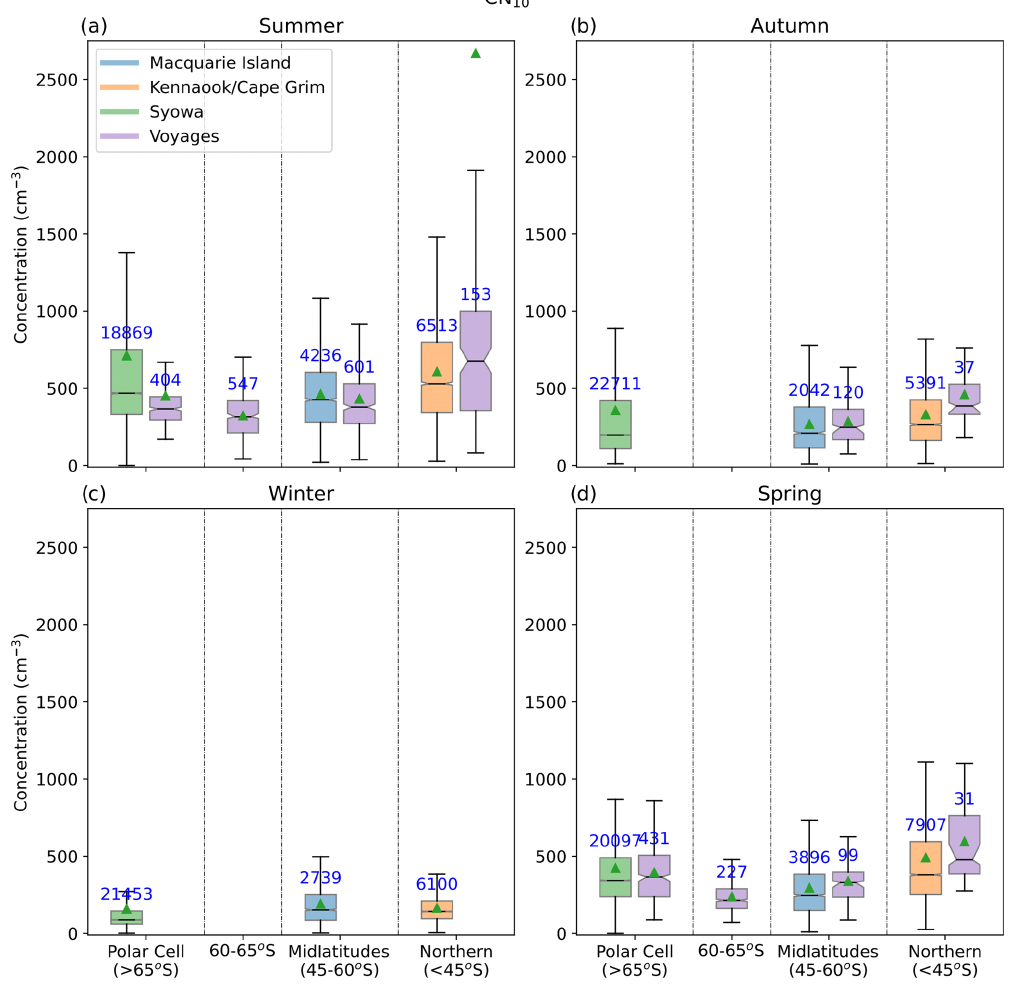
Figure A6. As in Fig. 4 but with y axis limits kept the same across all seasons.